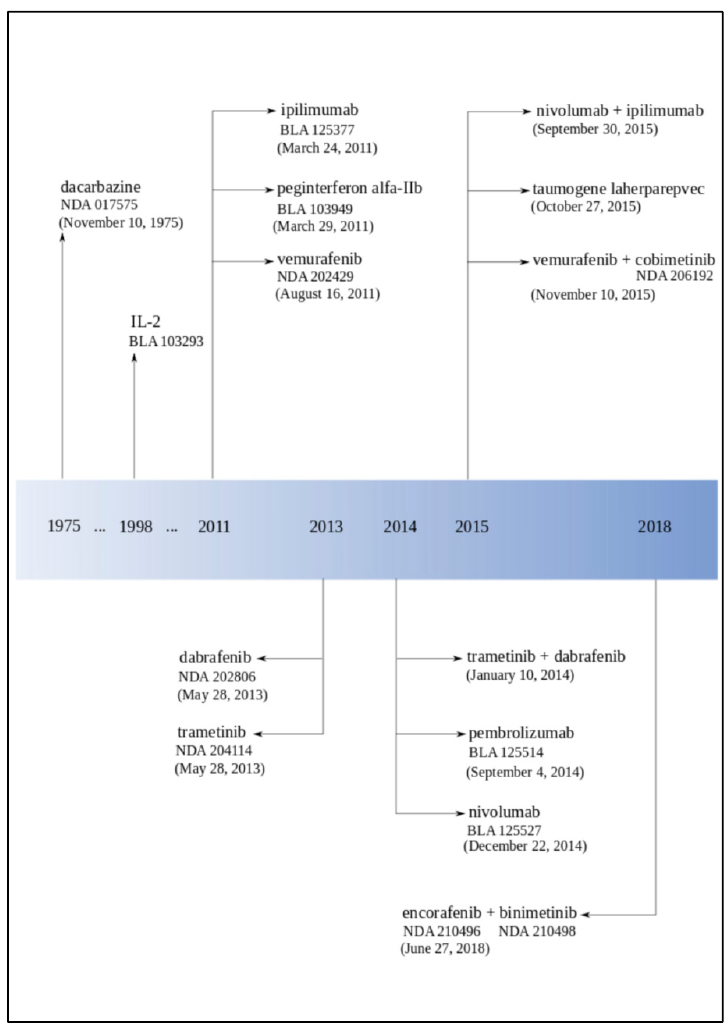
Figure 3. The Food and Drug Administration ( FDA) approvals for melanoma drugs timeline